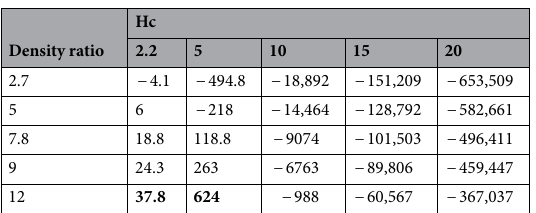
Table 7. Interaction effect of piston relative density and Hc. Significant values are in